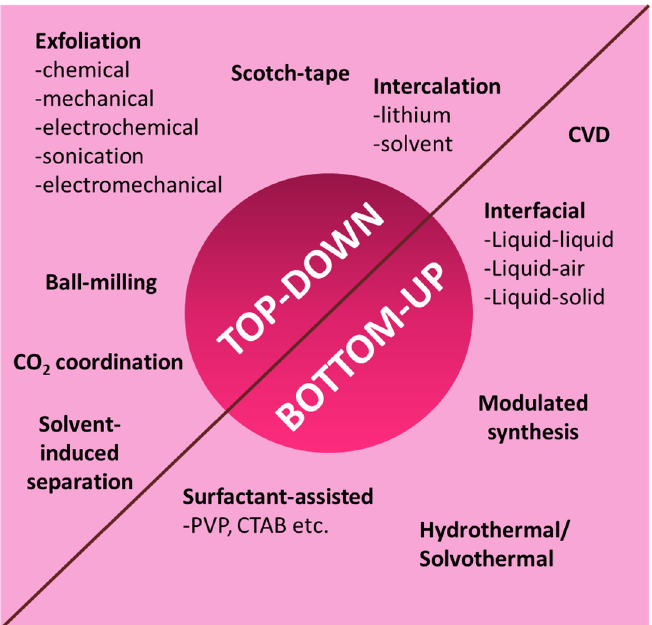
Figure 3. Schematic illustration of different synthesis routes of 2D MOF.